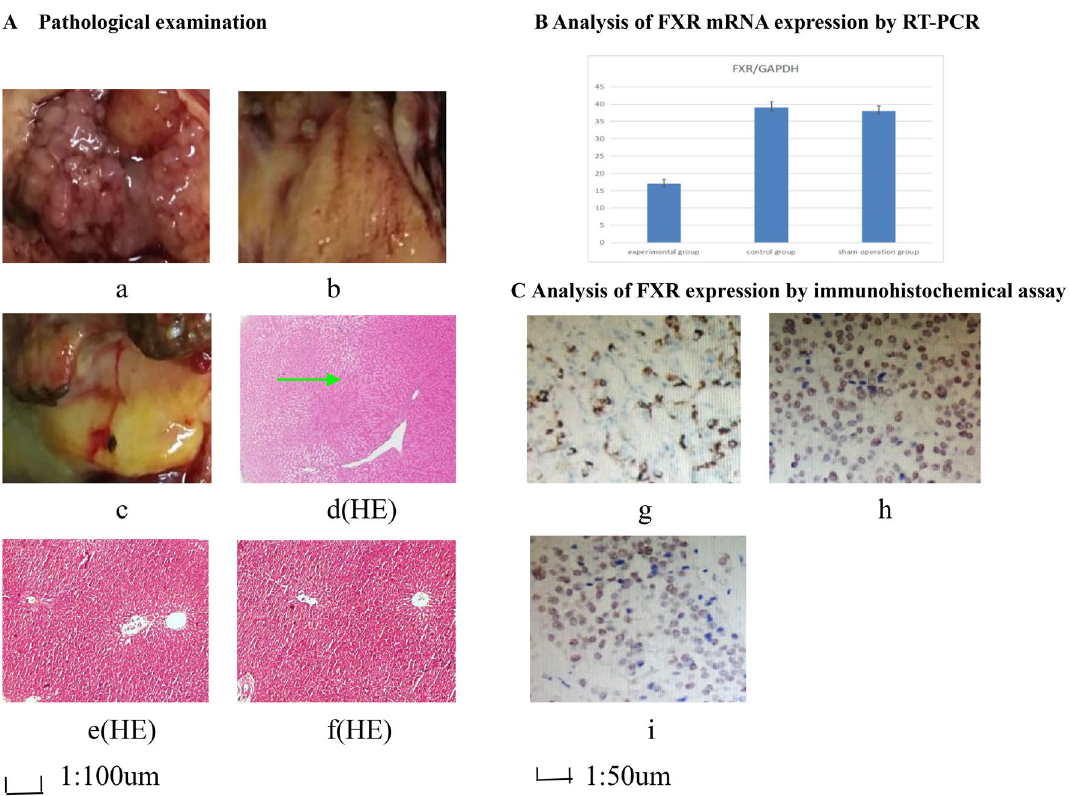
Figure 1. Pathological examination, RT-PCR and immunohistochemical assay. ( A ) Pathological examination. (a) hilar cholangiocarcinoma in experimental group; (b) hilar bile duct in control group. (c) hilar bile duct in sham operation group; (d) the lobulated masses are indicated by the green arrow in hilar cholangiocarcinoma. HE stain (magnification 100 ×). (e) hilar bile duct tissues in control group. HE stain (magnification 100 ×). (f) hilar bile duct tissues in sham operation group. HE stain (magnification 100×). One and half months later, hilar cholangiocarcinoma was detected in 16 rats in the experimental group, they are lobulated masses. But in control group and sham operation group only there were mild inflammation and edema in hilar bile ducts, and a small amount of inflammatory cell infiltration. The tumour cells were multinucleated and the endoplasmic reticulum was swollen. The cells in the control group and the sham operation group were slightly edematous. ( B ) Analysis of FXR mRNA expression by RT-PCR. Through RT-PCR we found that in hilar cholangiocarcinoma, control group and sham operation group the FXR/Gapdh ratios were 17 ± 1.3, 39 ± 1.6 and 38 ± 1.5, respectively. After eight cycles, there was significant statistical difference among the three groups (between experimental group and control group, t = 3.217, P < 0.05, between experimental group and sham operation group, t = 3.185, P < 0.05). ( C ) Analysis of FXR expression by immunohistochemical assay. (g) FXR expression in hilar cholangiocarcinoma of experimental group (magnification 200 ×). (h) FXR expression in normal hilar bile duct of control group (magnification 200×). (i) FXR expression in normal hilar bile duct of sham operation group (magnification 200×). FXR protein reacted with the anti-FXR antibody, and FXR protein expression is shown. Every pathological section included 4800 cells. 1856 positive cells (38.7%) were in the experimental group 3279 positive cells (68.3%) were in the control group, and 3371 positive cells (70.2%) were in the sham operation group, there was significant statistical difference among the three groups ( χ 2 = 33.97, P < 0.05, between experimental group and sham operation group. χ 2 = 33.16, P < 0.05, between experimental group and control